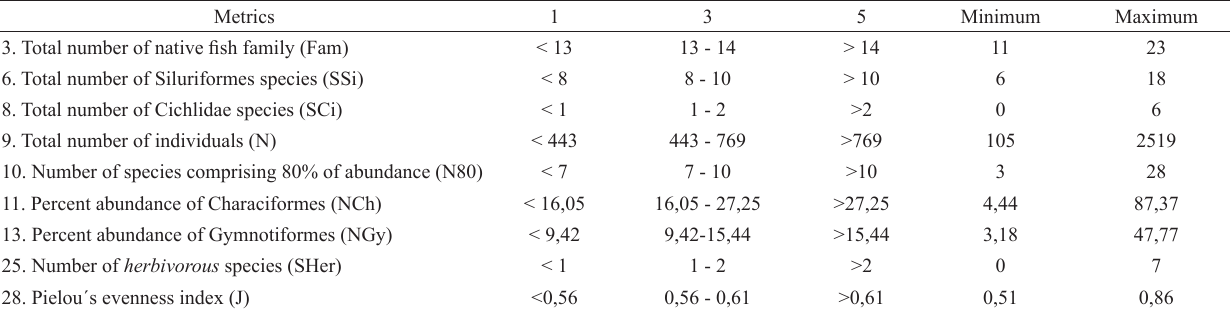
Tab. 3. Score intervals and ranges of values of the metrics for calculating the IBI